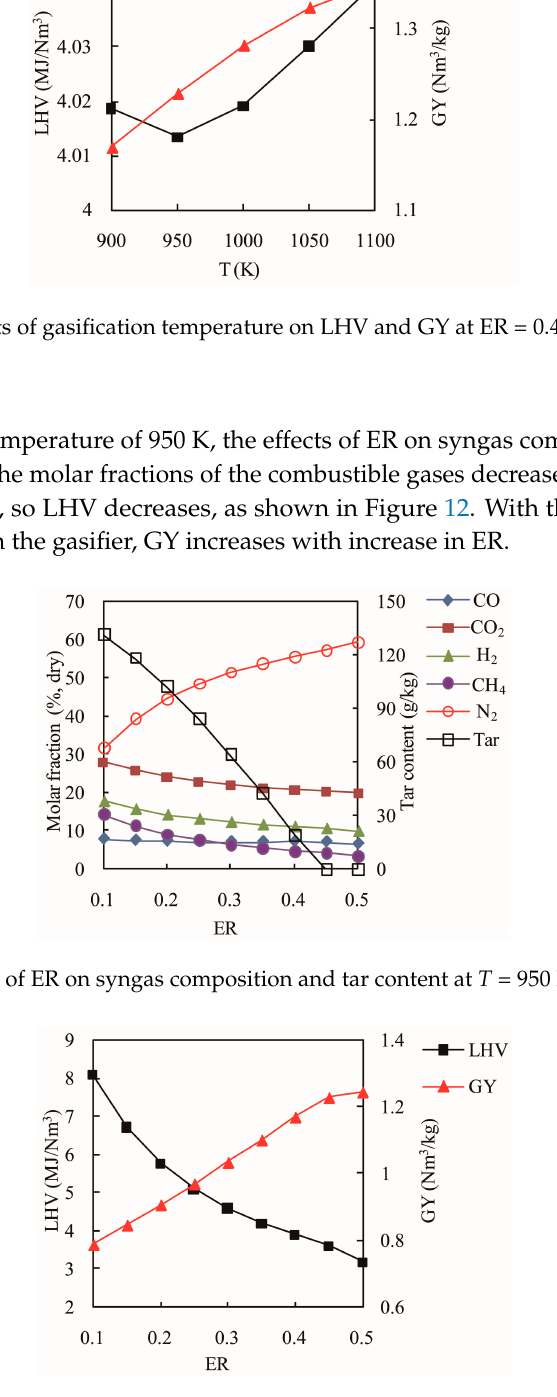
Figure 12. Effects of ER on LHV and GY at T = 950 K and SBR = 0.3.